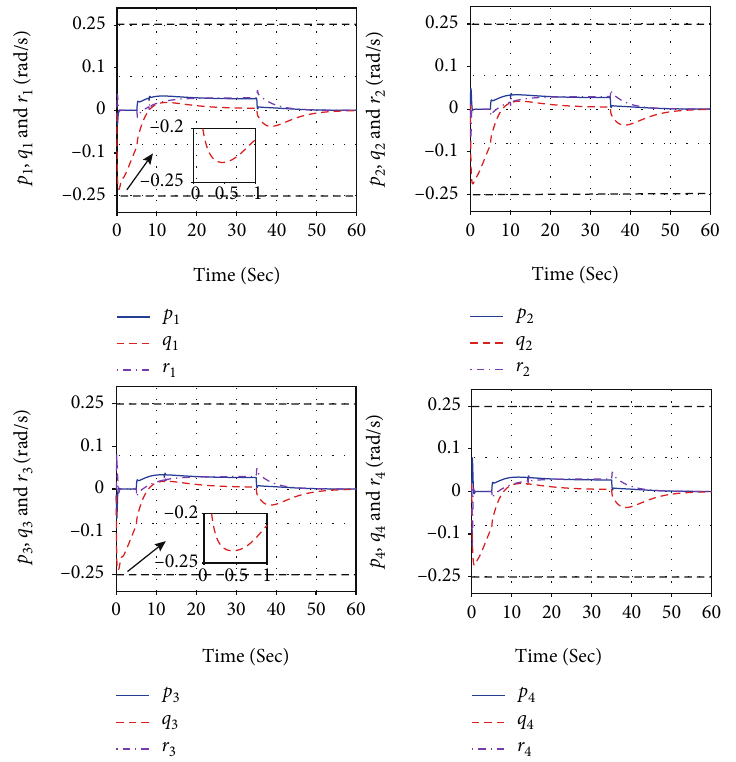
Figure 7: The time responses of p